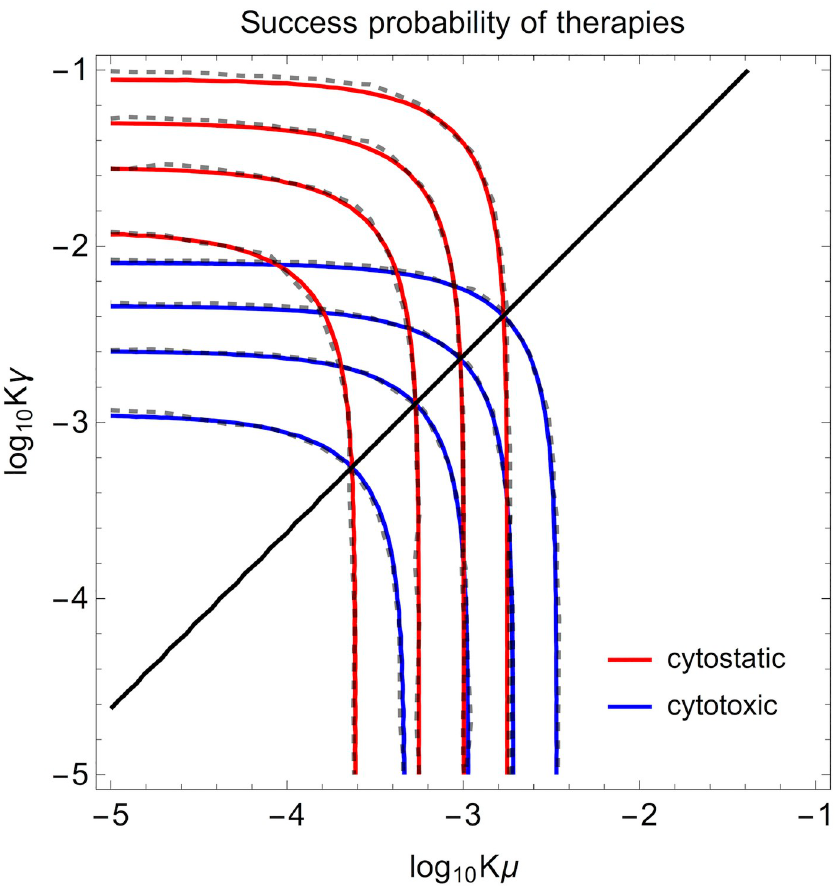
Fig 3. Case primary tumour declines. Isocontours for therapy success (0.2, 0.4, 0.6, 0.8, with upmost contours representing smallest values) from Eq 8 for cytotoxic treatments (blue) and cytostatic treatments (red). Shown is the plane in metastasis rate ( K μ ) and mutation probability ( K γ ) multiplied by the population size at carrying capacity. Black thick line shows the transition from cytostatic better (left side) to cytotoxic better (right side) which takes place at β 0 γ = μ . Low turnover case ( β 0 = 0.42, δ 0 = 0.02, Δ = 0.2001), simulation data plotted with dashed lines. Primary tumour decayed with rate r 0 = −